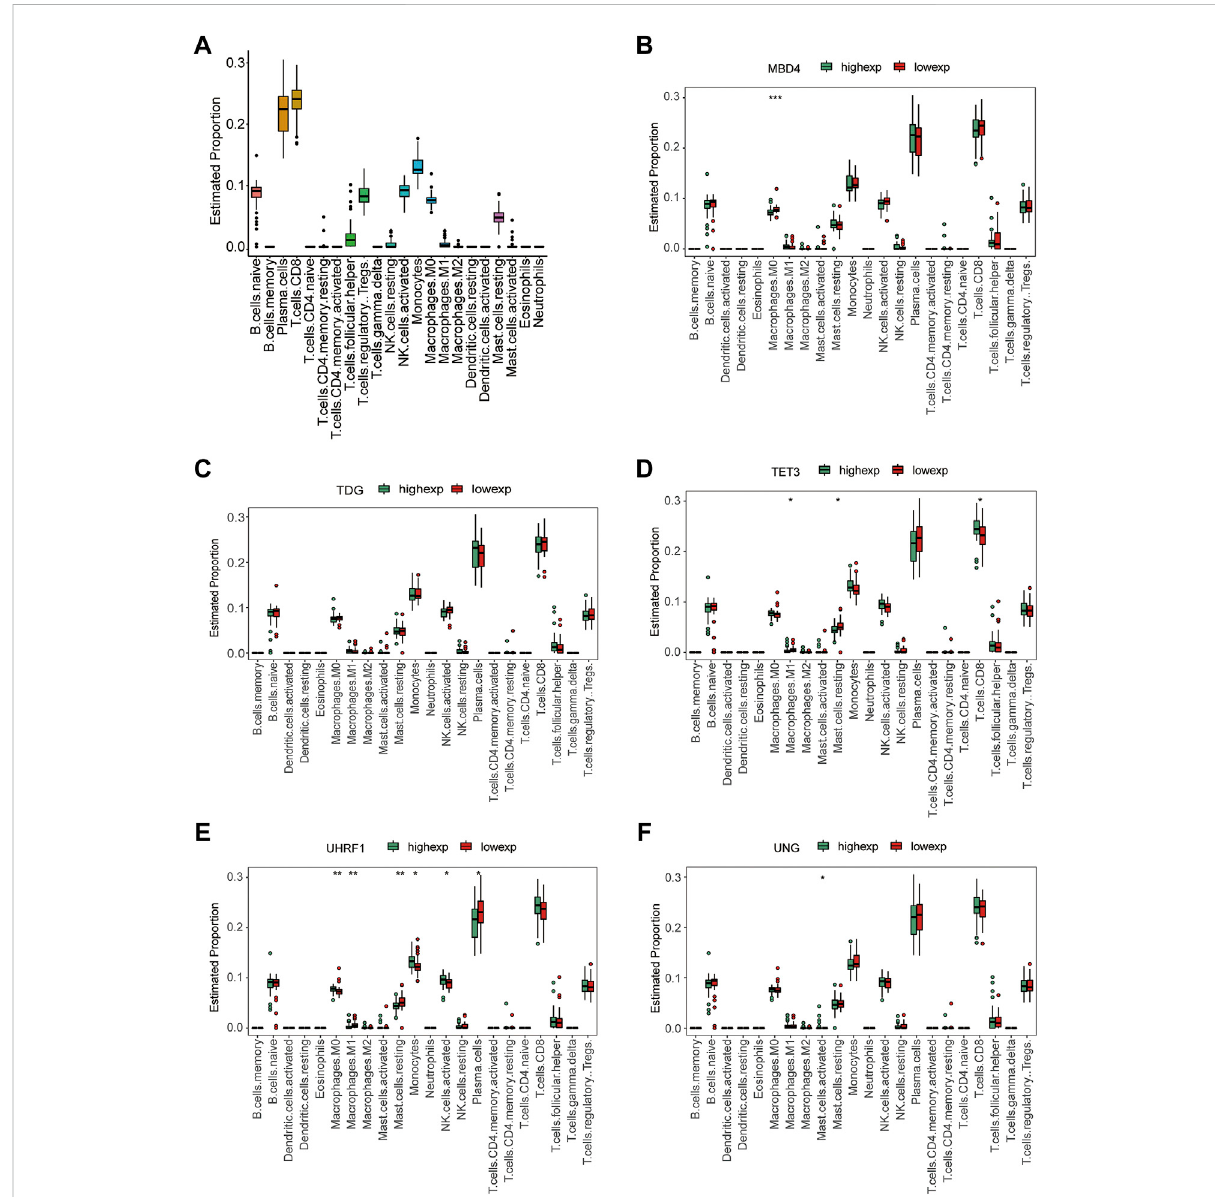
FIGURE 11 Immune in fi ltration analysis. (A) Boxplot of the proportion of 22 types of immune cells. (B – F) Immune cell in fi ltration characteristics between high gene expression and low gene expression groups: (B) MBD4 , (C) TDG , (D) TET3 , (E) UHRF1 , and (F) UNG